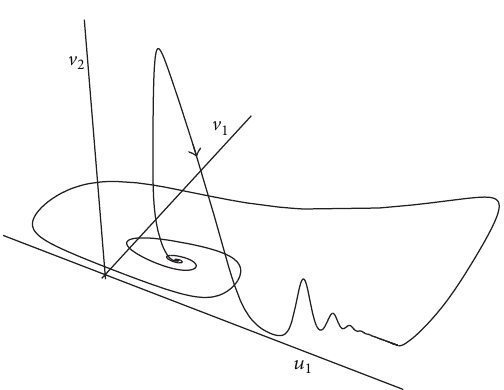
Figure 8: A 3D-projection of the limit cycle in system (1a)–(1d) for parameters chosen in a neighborhood of the heteroclinic cycle. See caption to Figure 6(b) for the